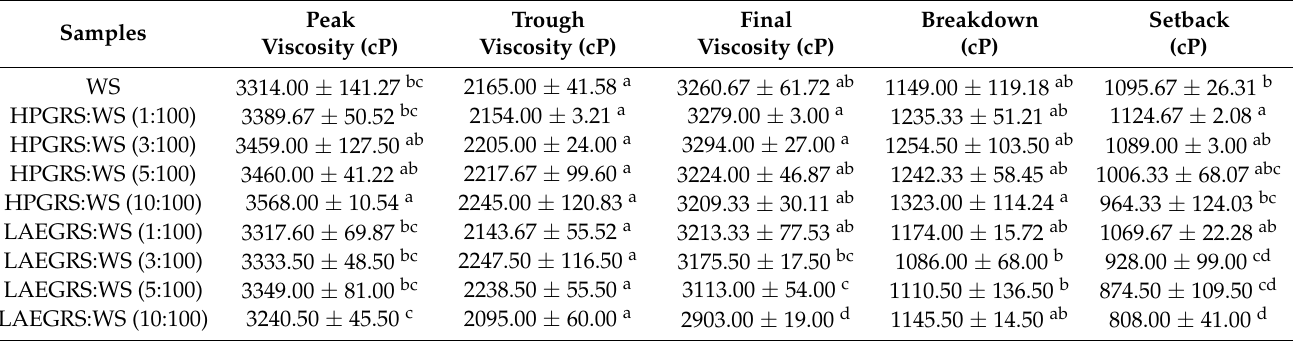
Table 2. Pasting properties of different proportions of HPGRS and LAEGRS (0%, 1%, 3%, 5%, and 10%) blended with WS